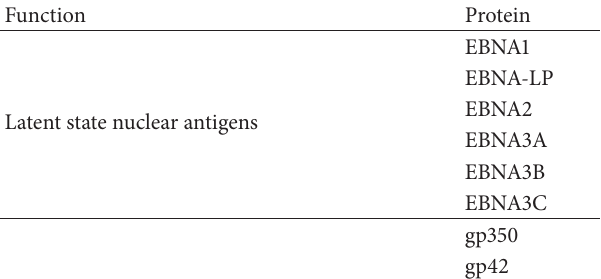
Table 2: Selection of Epstein-Barr virus proteins and their functions [33, 39].